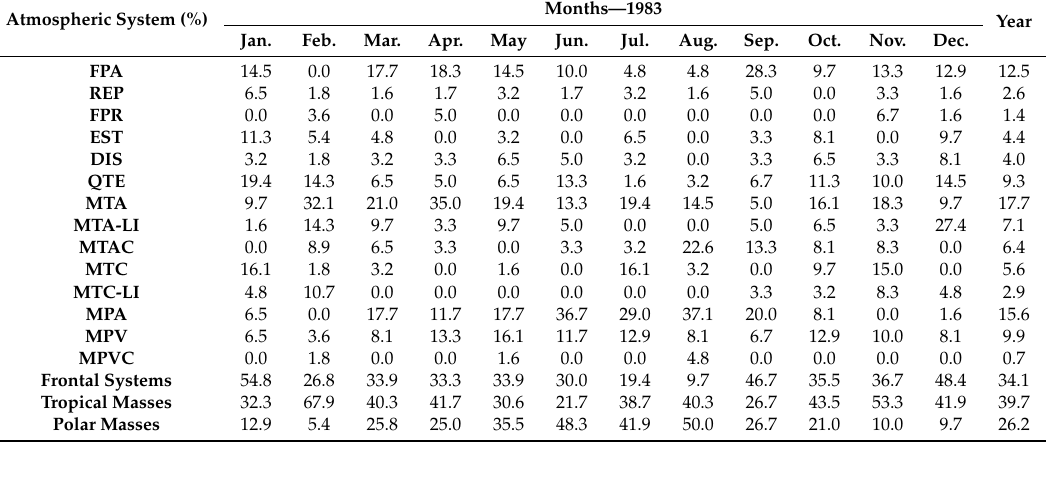
Table 4. Atmospheric systems frequency at the monthly level in the year 1983.